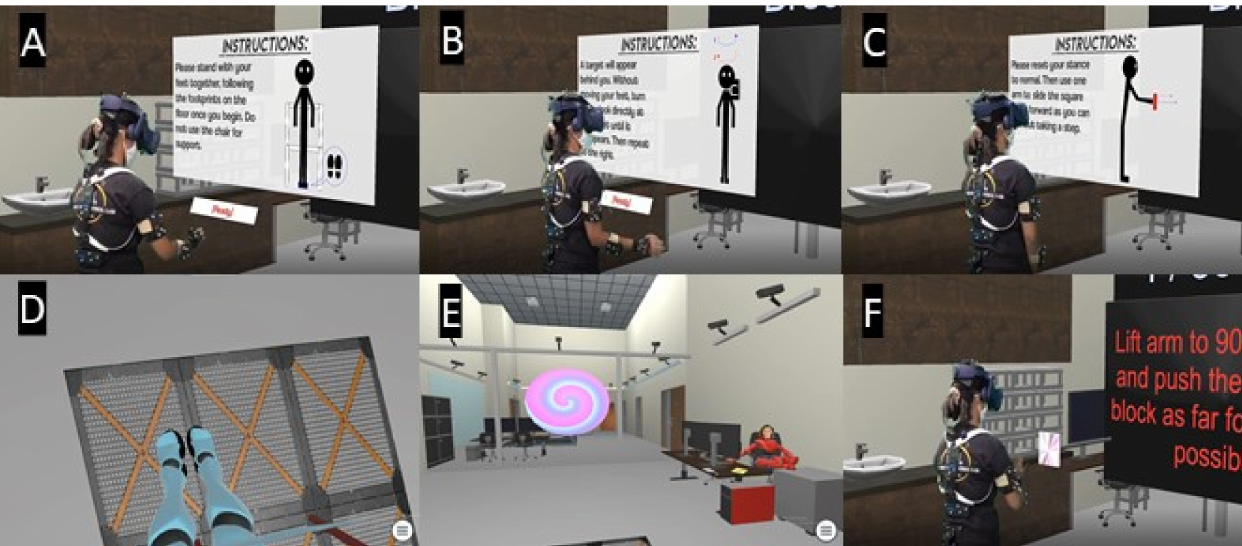
Figure 2. A representation of Virtual Reality Berg-Balance Scale ((VR-BBS) A , D ) Narrow stance, the instructions read: Please stand with your feet together, following the footprints on the flow once you begin. Do not use the chair for support. ((task 4 in VR and task 7 in the standard BBS, see Table 1), B , E ) Turning to look behind over left and right shoulder while standing. The instructions read: A target will appear behind you. Without moving your feet, turn to look directly at the target to the left until it disappears. Then repeat to the right. ((VR-BBS task 6 standard BBS task 10) and C , F ) Reaching forward with outstretched arm while standing. The instructions read: Please reset your stance to normal. Then use one arm to slide the square as far forward as you can without taking a step. ((VR-BBS task 5 standard BBS task